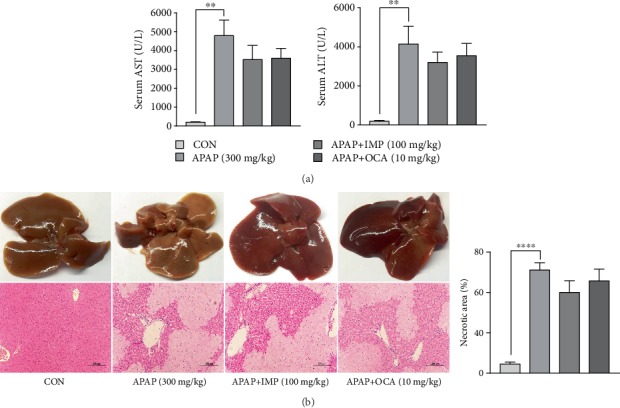
FXR knockout abolishes the protective effects of IMP against APAP overdose-induced ALI and necrotic death. (a) Serum was harvested for measurement of ALT and AST levels. (b) Changes in the appearance of solid liver tissue and representative images of H&E staining in FXR−/− mouse (with/without IMP pretreatment) liver sections at 10 h after APAP injection (magnification: 200x). Results are compared to the vehicle-treated control group. ∗p < 0.05; ∗∗p < 0.01; ∗∗∗p < 0.001 versus vehicle-treated control group. ALT: alanine aminotransferase; AST: aspartate transaminase.